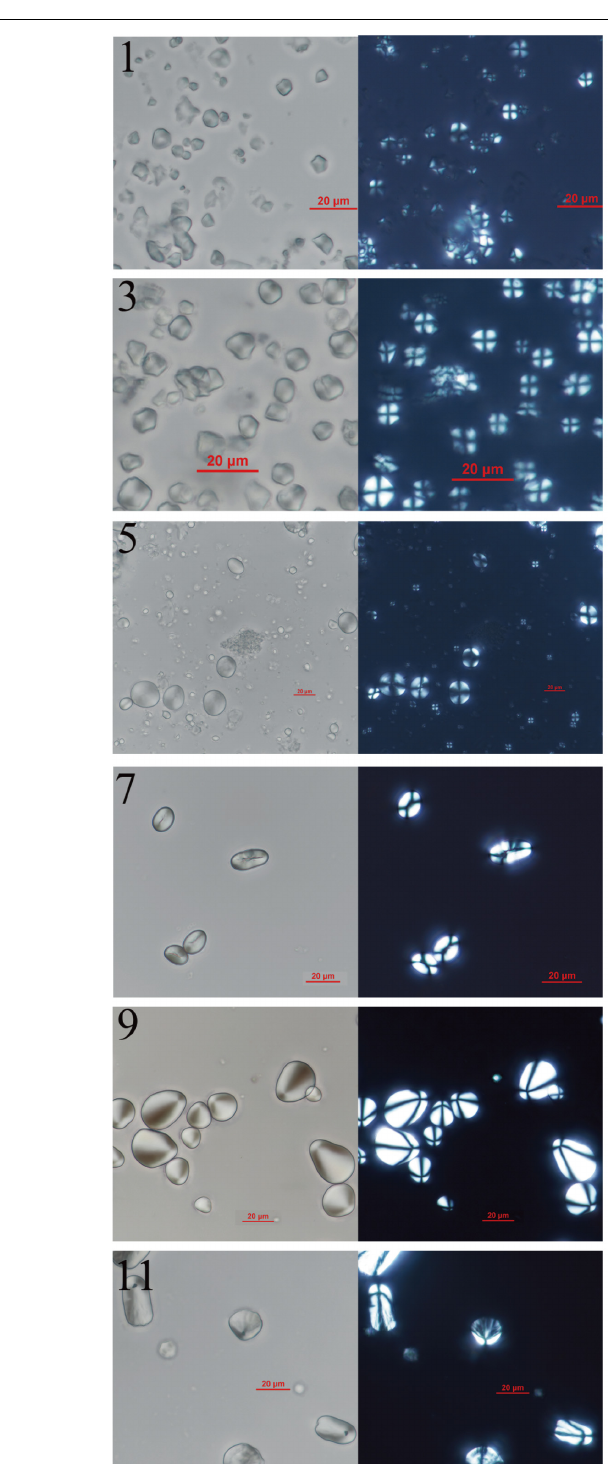
Frontiers in Ecology and Evolution |